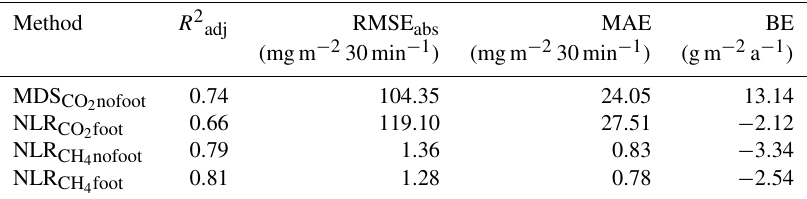
Table 2. Gap-filling model performance was estimated according to Moffat et al. (2007) with several measures ( n CO fluxes of best quality QC 0): the adjusted coefficient of determination R 2 <2.2 × 10 − 16 ) , the absolute root mean square index (RMSE abs ) and the mean absolute error (MAE) for the magnitude and distribution of individual errors, as well as the bias error (BE) for the bias of the annual sums.